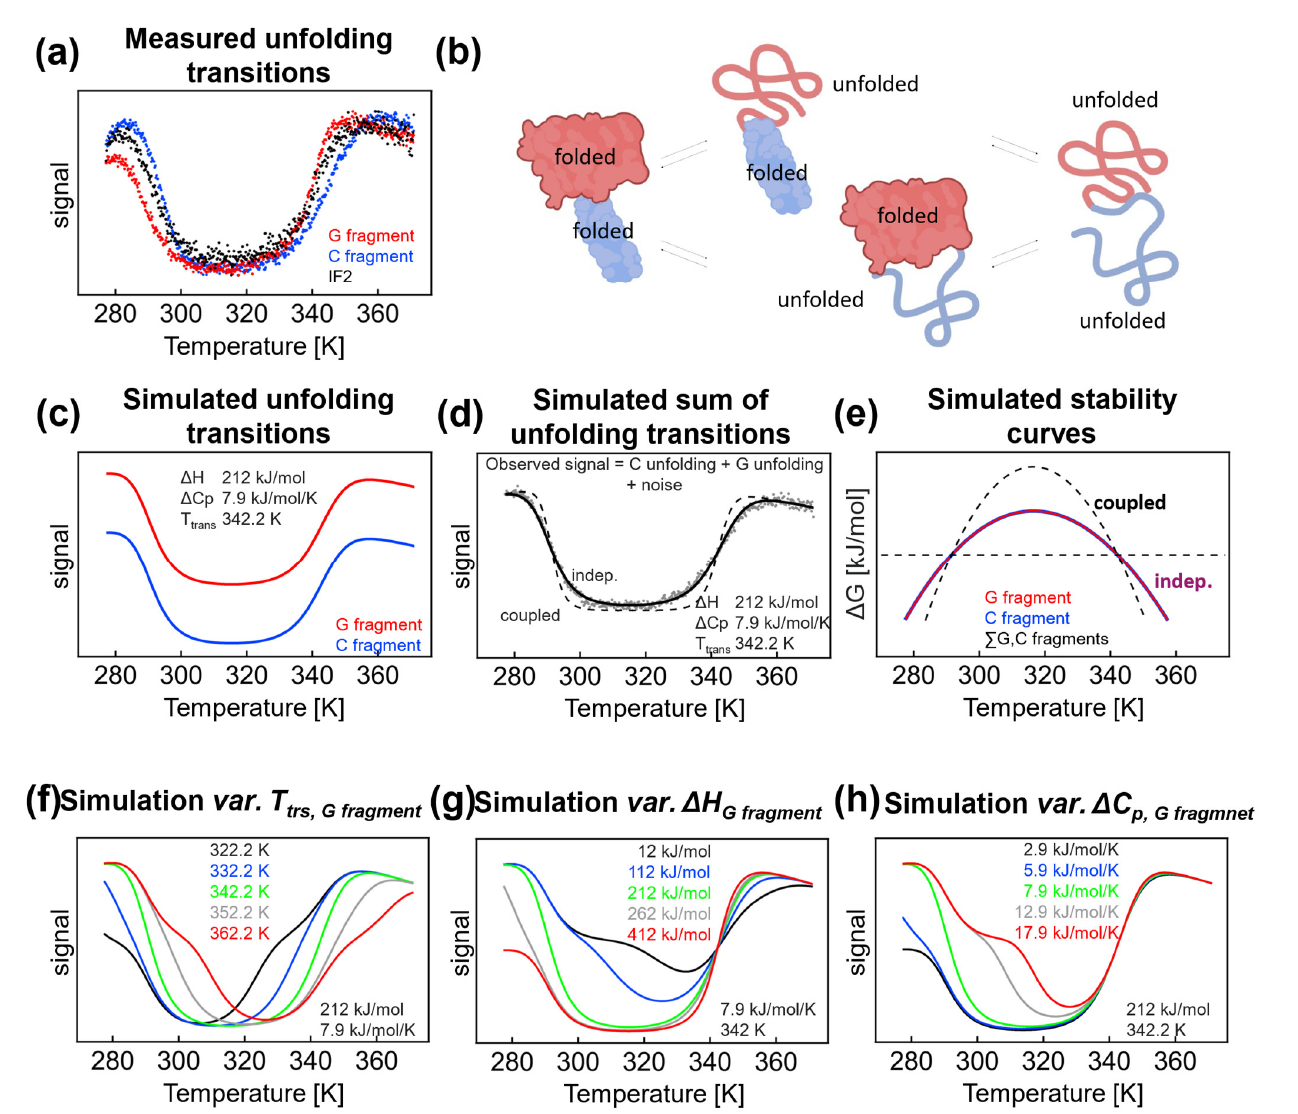
Figure 3. ( a ) The thermal denaturation of the G fragment (red), C fragment (blue), and full-length IF2 (black) measured by circular dichroism at 222 nm. ( b ) Two denaturation pathways of IF2: in one pathway, denaturation starts with the C fragment, and in the second pathway, denaturation starts with the G fragment. When the fragments have equal stability and are independent, then both path- ways are present. ( c ) Independent unfolding of G and C fragments in which transitions are de- scribed by the same thermodynamic parameters. ( d ) Simulation of unfolding transition of IF2 in the case when the denaturation of both G and C fragments is coupled (dashed line) and independent (solid line) and measured data (gray dots). In simulations, data are described by the same parame- ters. ( e ) Simulated stability curves for independent G/C fragments (solid red and blue line) and cou- pled fragments (dashed black line) described by the same thermodynamic parameters as in ( d ). Simulation of changes in the thermal unfolding profile when the denaturation parameters for the C fragment are held constant (Δ H 212 kJ/mol/K, Δ c p 7.9 kJ/mol, T t rs , hot 342.2 K) while one of the param- eters for the G fragment is varied ( f ) variable T trs , hot , Δ H 212 kJ/mol/K, and Δ c p 7.9 kJ/mol and ( g ) T trs , hot 342.2 K, variable Δ H , and Δ c p 7.9 kJ/mol. ( h ) Simulated effect of changes in the values of the heat capacity for the G fragment with the other values held constant. See also Figures S3–S5, Supplemen- tary Materials.